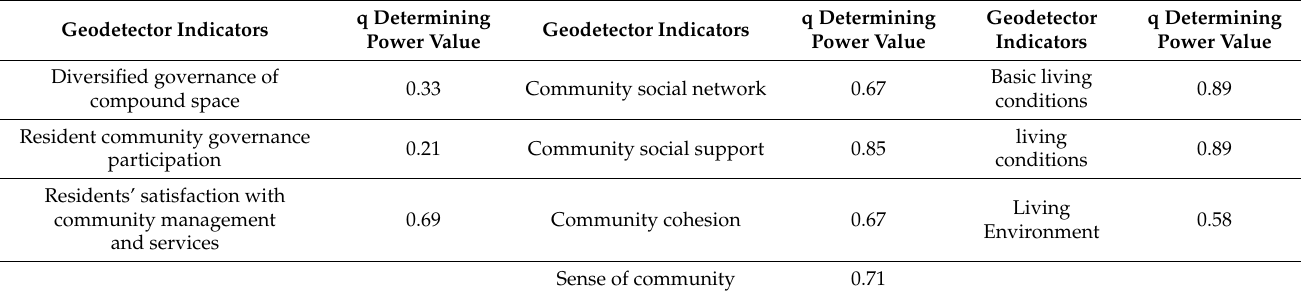
Table 3. Three-dimensional spatial coupling influencing factor q of spatial production determines the value of force. Geodetector